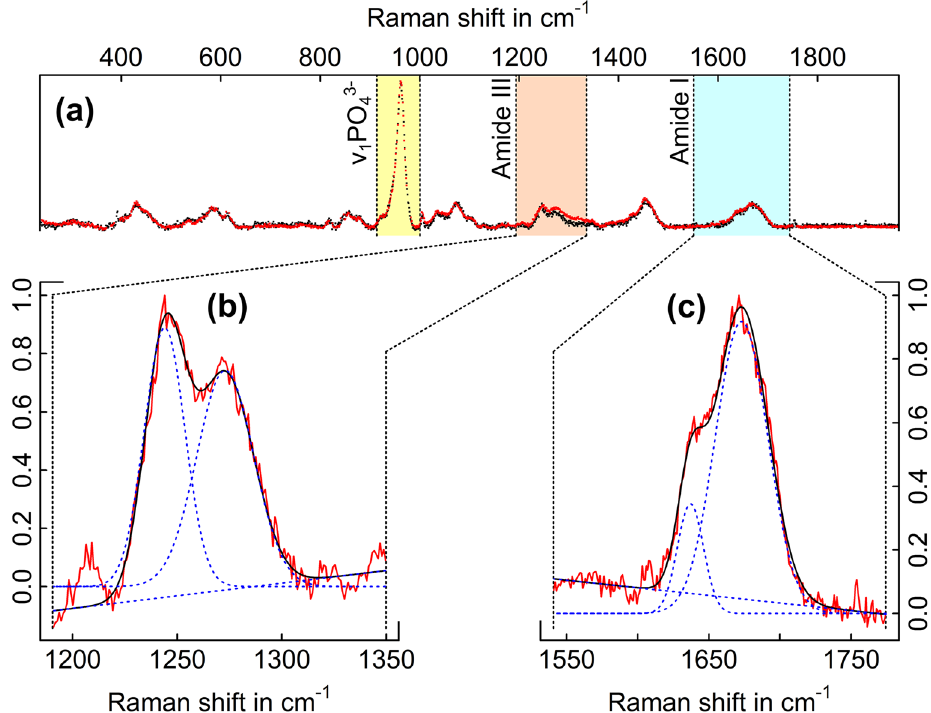
Figure 3. Raman spectral analysis. ( a ) Baseline corrected spectra of an ultramilled (black) and laser ablated pre-pillar (red) measurement. All y-axis values, intensity counts, are normalised in each of the graphs presented. ( b ) Gaussian fitting of the Amide III spectral response. ( c ) Gaussian fitting of the Amide I spectral response. Unsmoothed data was fitted with respect to each components given